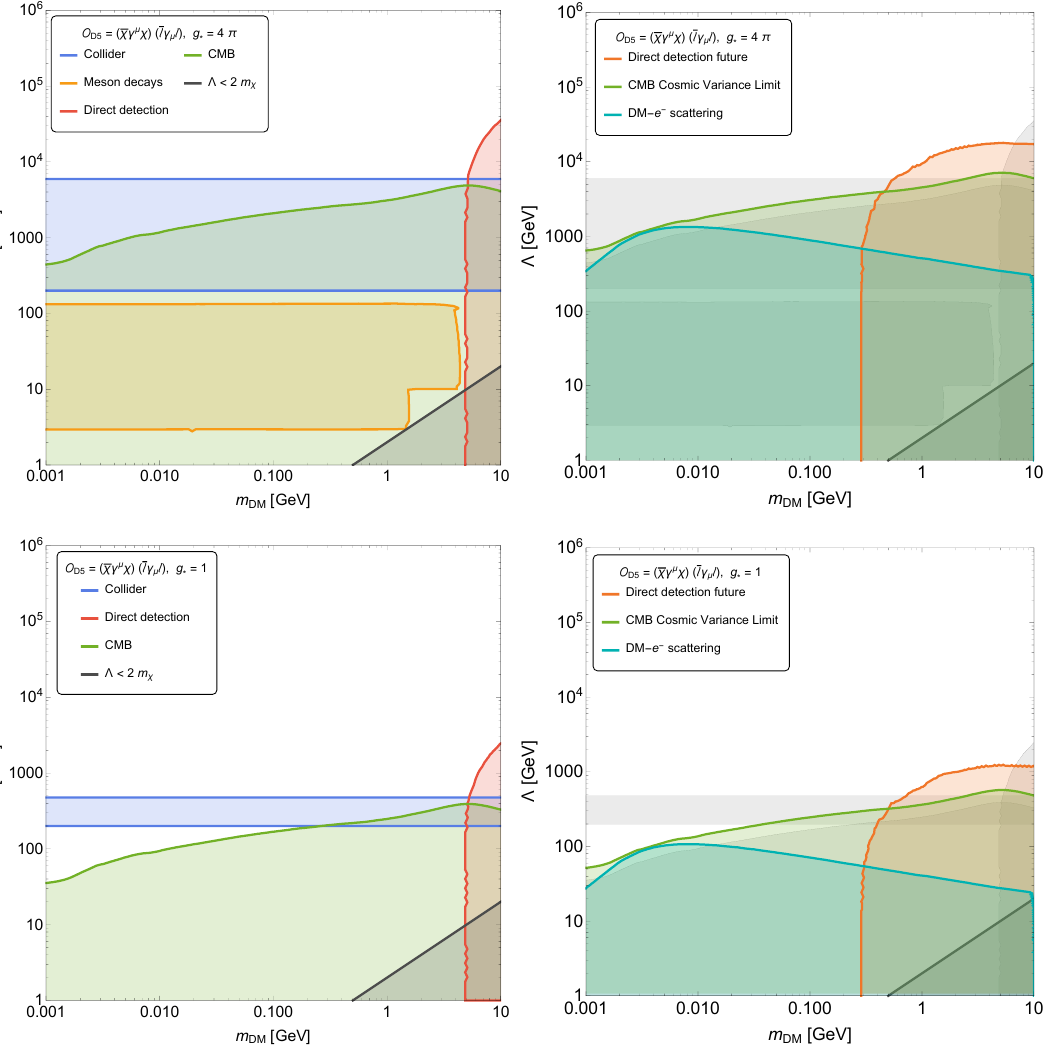
Figure 2 . Same as (cid:12)gure 1, but for universal couplings to